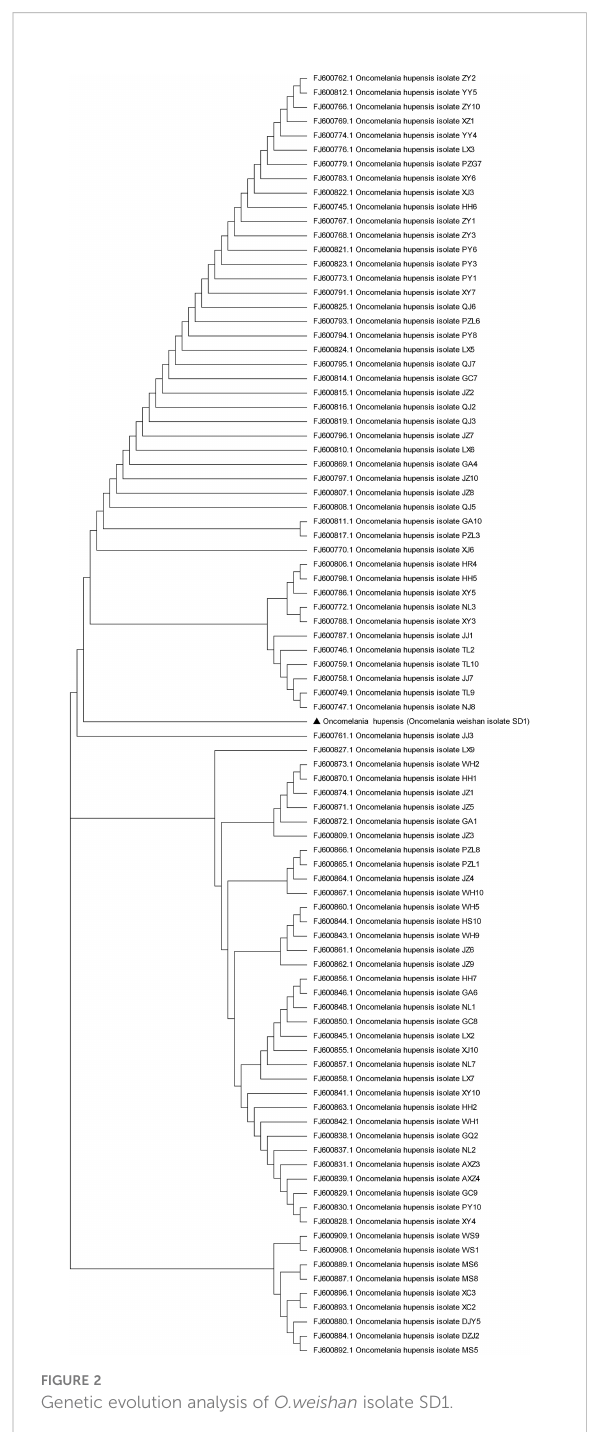
FIGURE 2 Genetic evolution analysis of O.weishan isolate